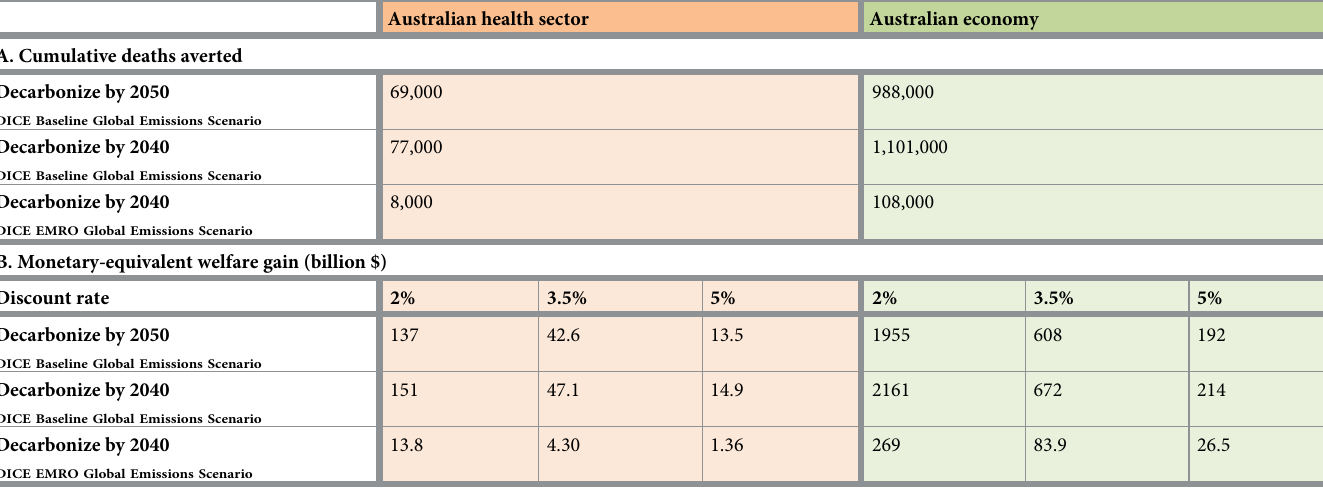
Table 1. A. The number of temperature-related deaths averted if Australia’s health system and the whole economy decarbonises by 2040 and 2050. B. The monetary equivalent welfare gain under a range of discount rates and emission trajectories.